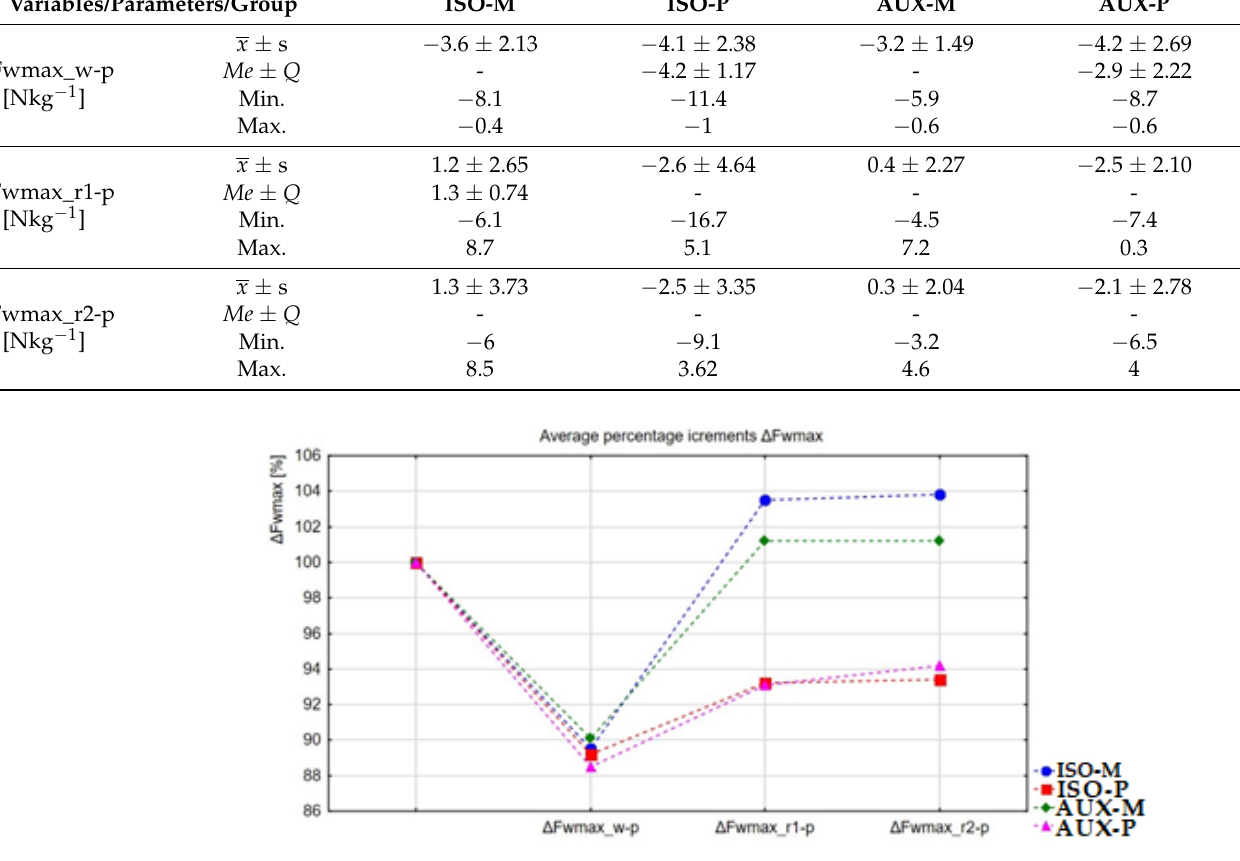
Table 2. Changes in the maximum relative strength compared to baseline expressed in Nkg- 1 , in individual stages of the experiment in groups of participants.